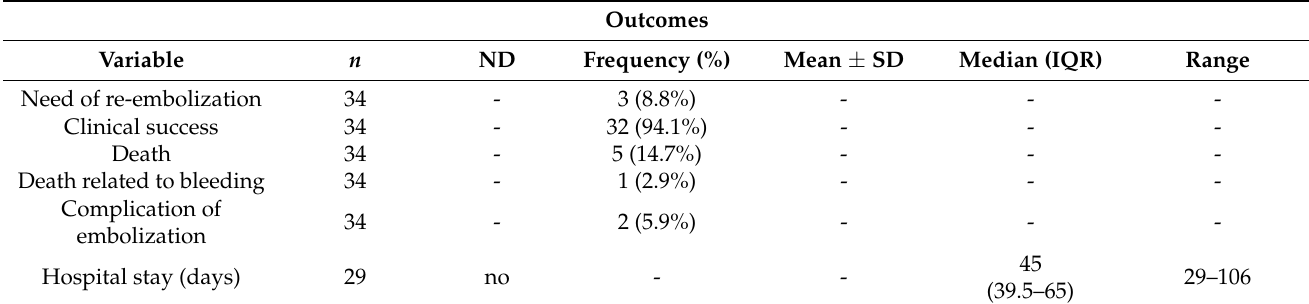
Table 6. Outcomes and descriptive statistics.